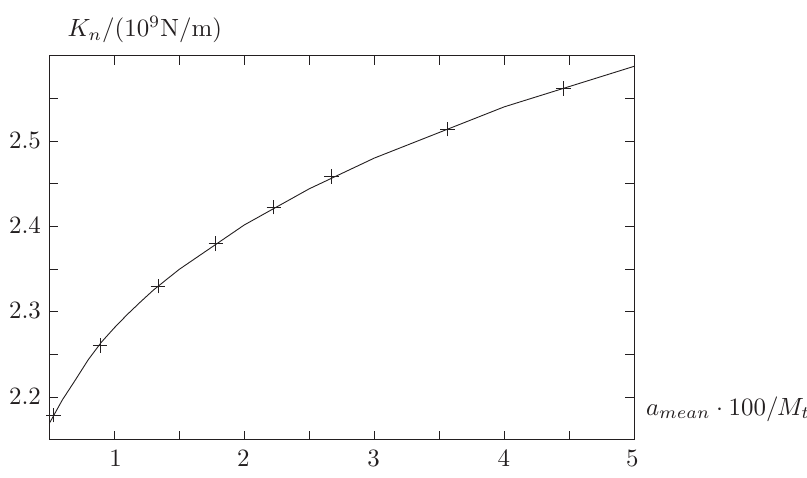
Figure 11: Helical tooth stiffness as a function of mean contact zone half-width under the assumption of evenly distribution of contact load along the contact line. The full line is for constant contact zone half- width, crosses are for varying (according to Hertzian distribution) contact zone half-width.